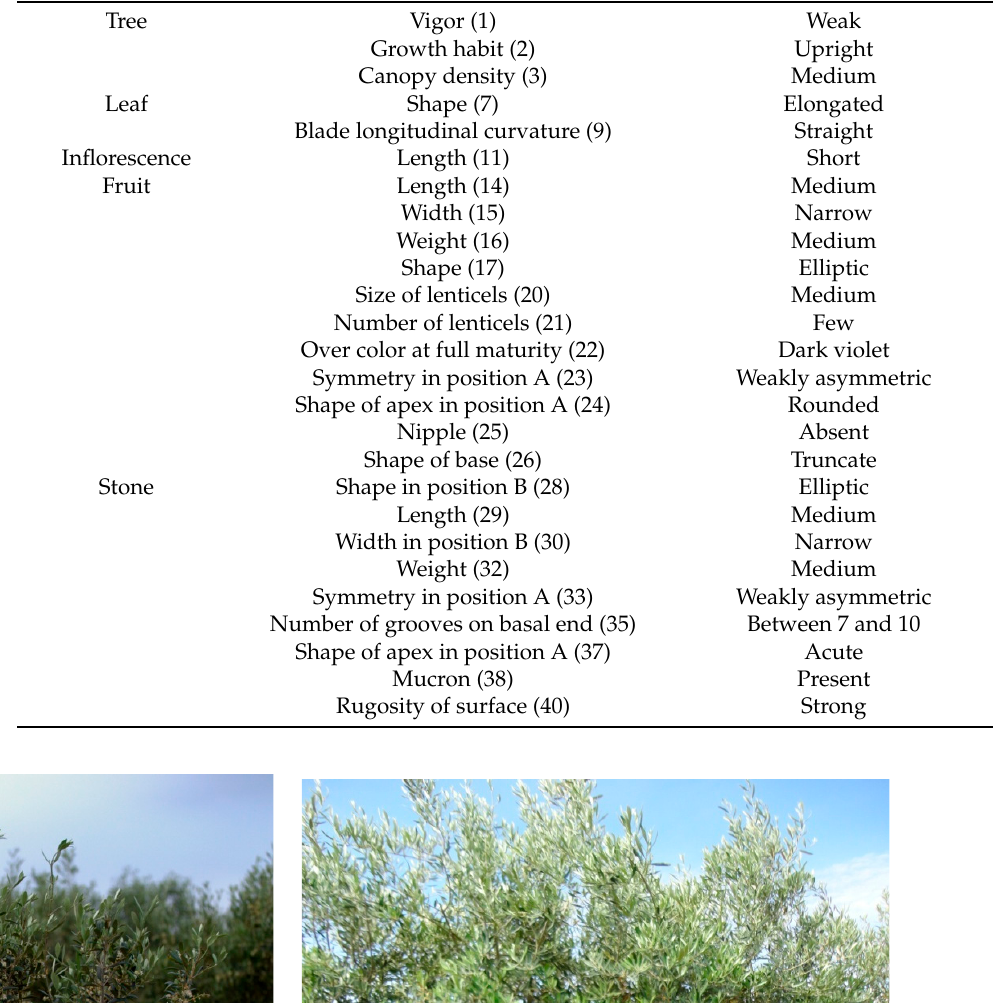
Table 2. Main morphological markers of ‘Lecciana’. Values of four subsequent seasons. The characteristic numbers referring to UPOV table TG/99/4 are reported for each marker in brackets.